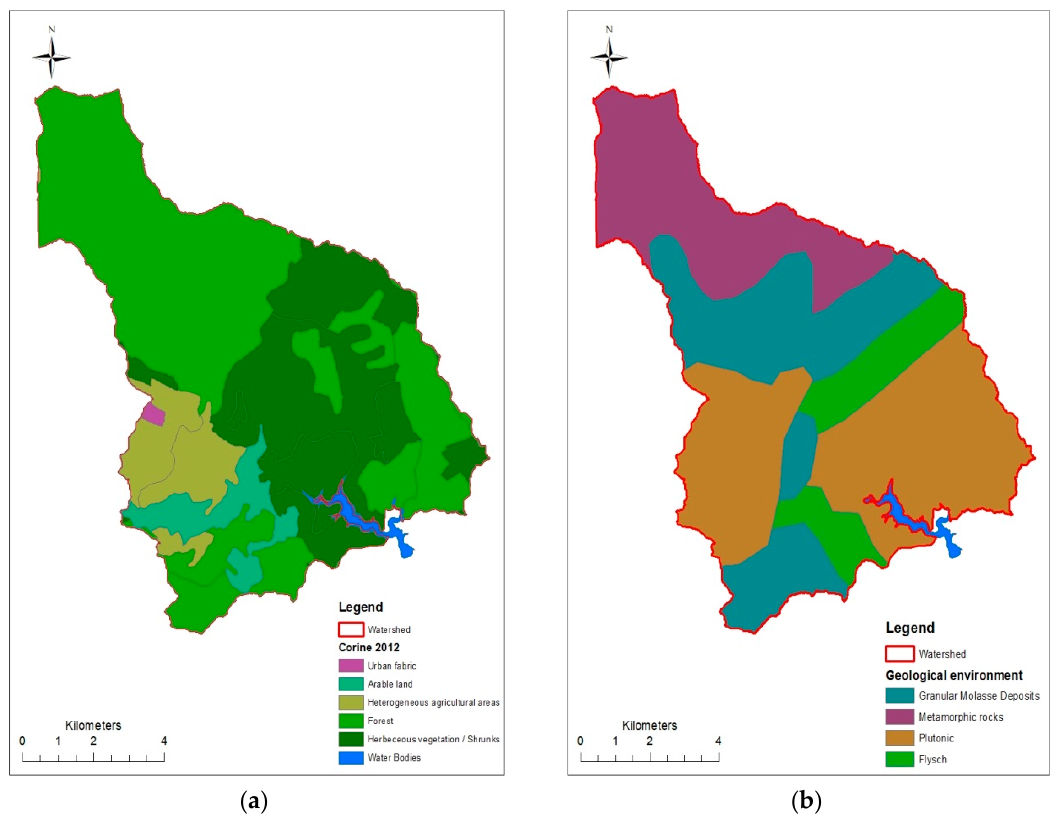
Figure 2. ( a ) Land use; ( b ) geological environment.